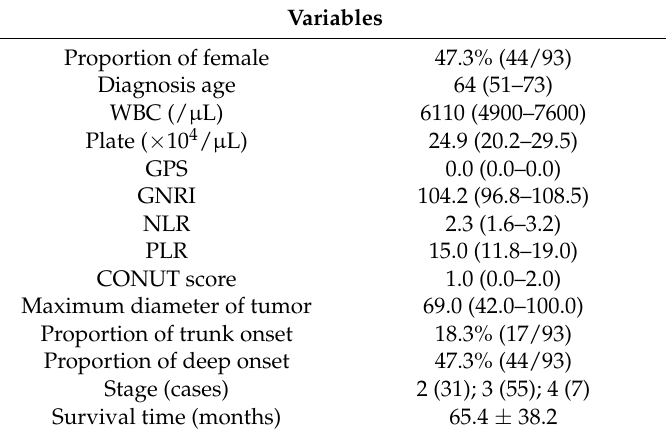
Table 5. Demographic data of STS patients with resection surgery.